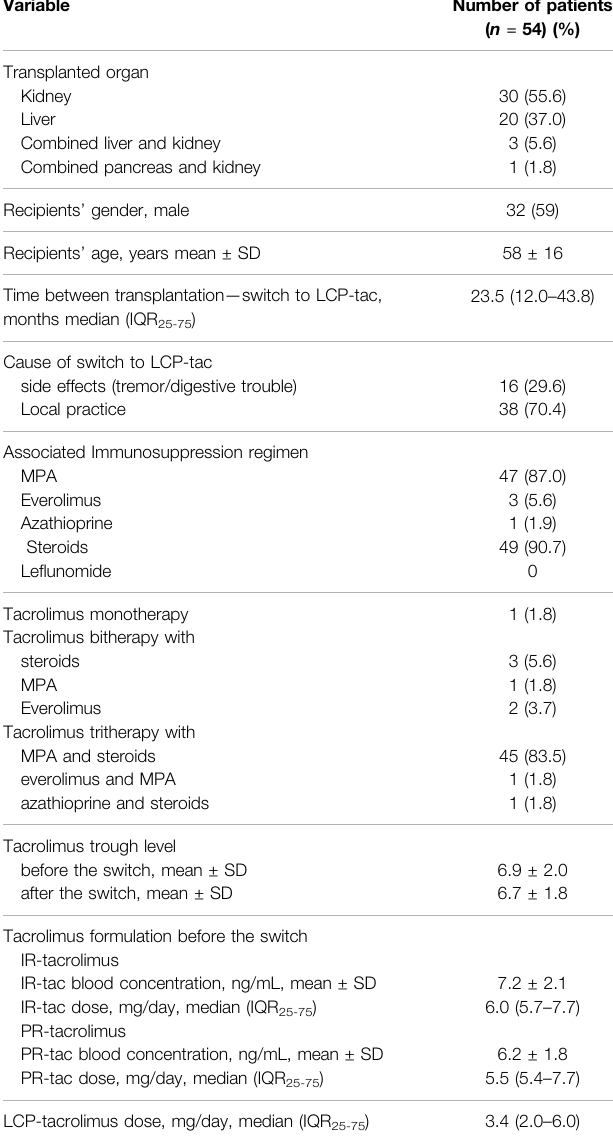
TABLE 1 | Mains characteristics of the patients included in the tacrolimus CV-IPV change after the switch to LCP-tacrolimus. Variable